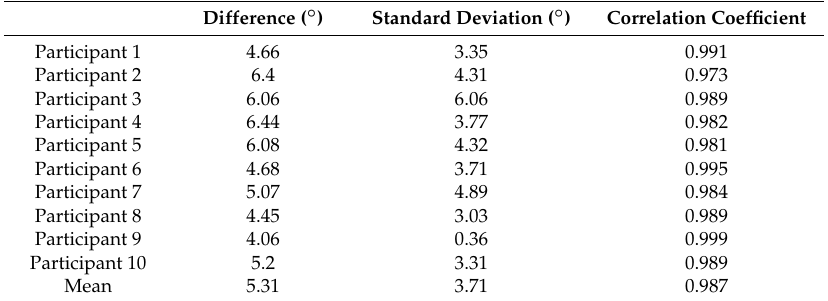
Table 2. Experimental results for dynamic tests realized in the elbow for each participant.